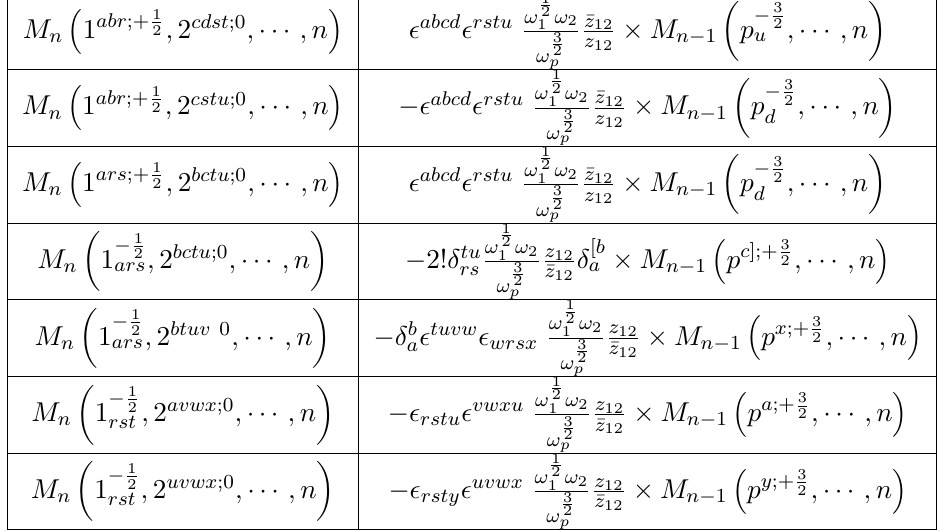
Table 14 . Amplitude corresponding to collinear graviphotino and scalar.